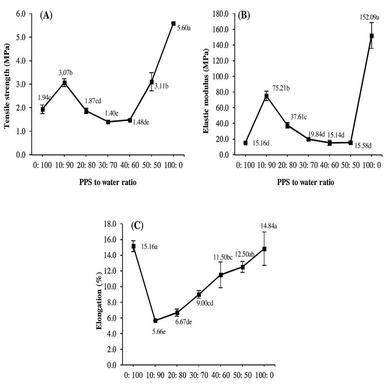
Mechanical properties of commercial pectin films affected by different pineapple peel extract solution (PPS) to water ratios: (A) tensile strength; (B) elastic modulus and (C) elongation at break. Means with the same letter are not significantly different (p < 0.05). The error bar represents the standard deviation.